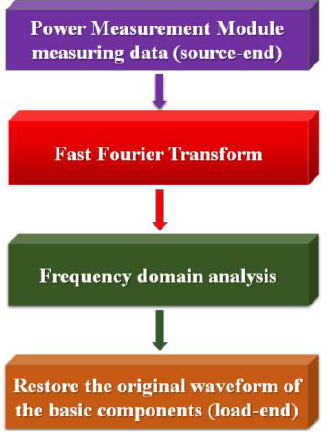
Figure A1. The proposed flow chart for power load analysis using the FFT approach.